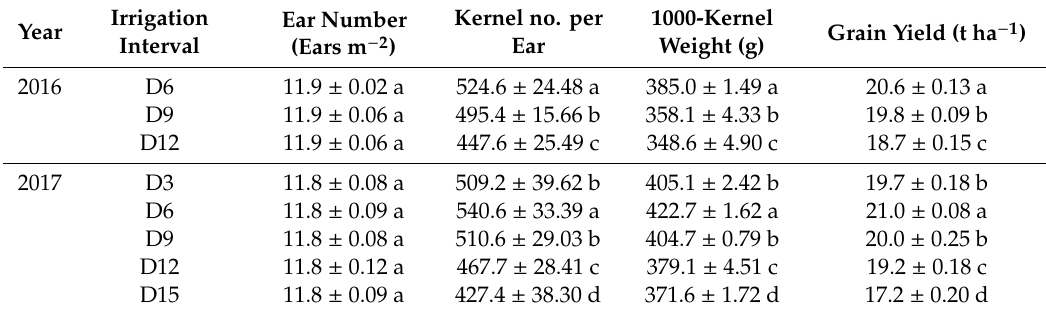
Table 1. Grain yield, ear number, kernel number, and kernel weight of maize at di ff erent irrigation intervals.